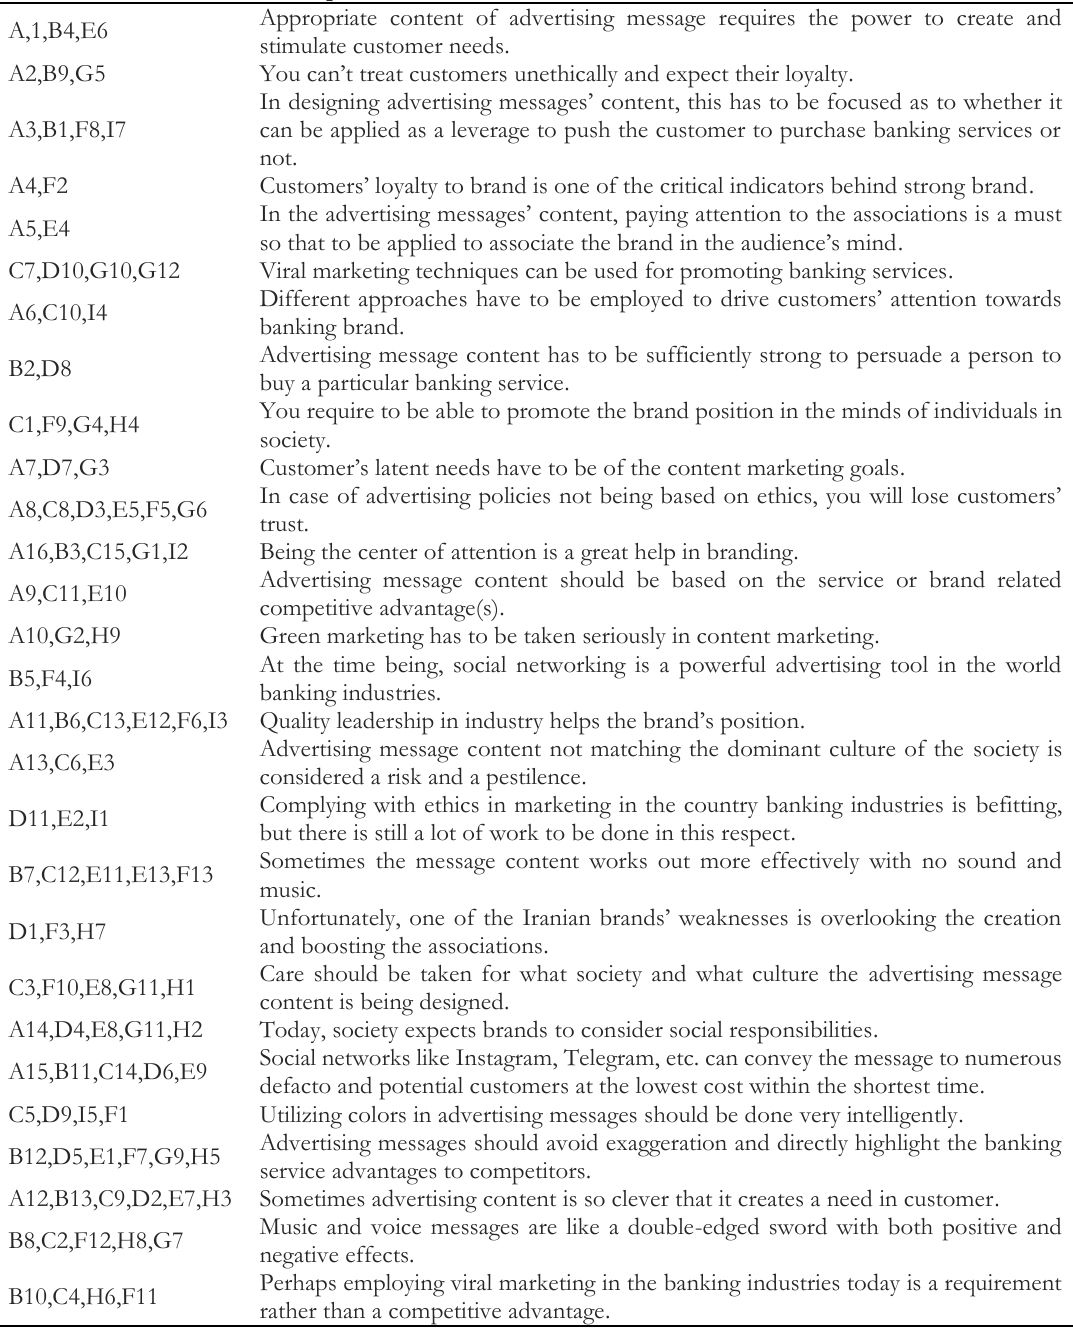
Table 2. Final concepts after analyzing interviews and crossing out repeated cases in open coding